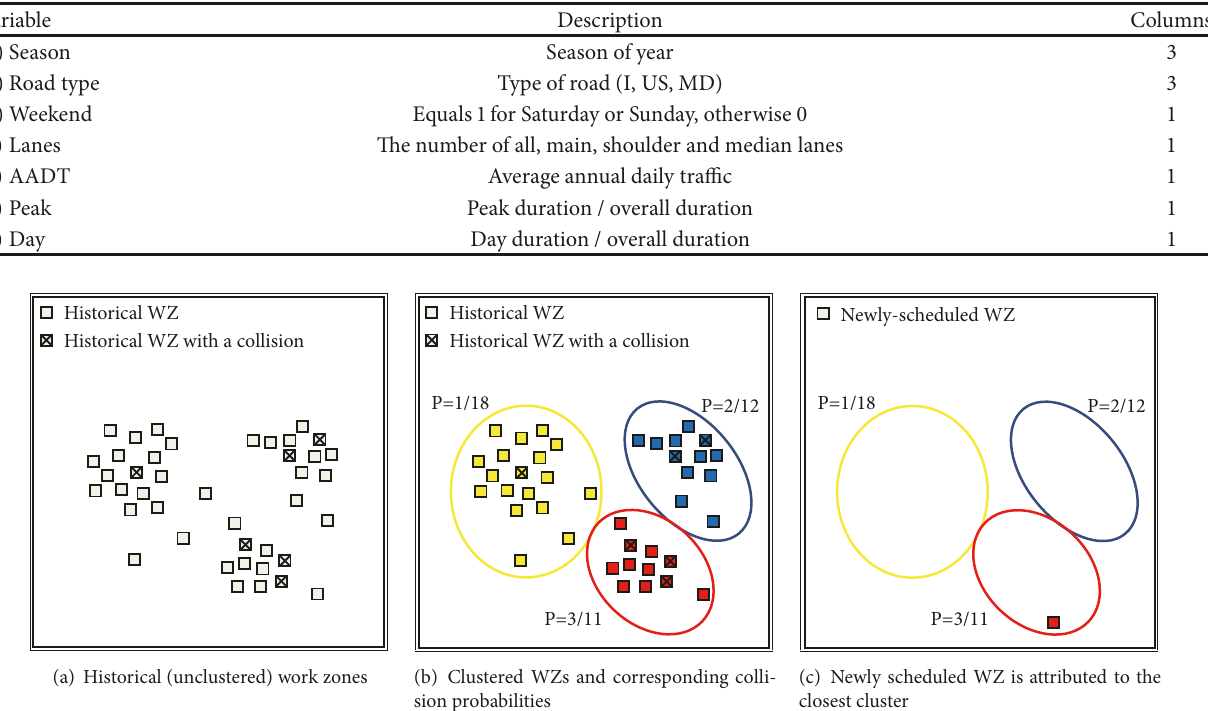
Figure 9: Graphical description of the methodology via a trivial example including 2 dimensions, 3 clusters, and 41 data points (i.e., WZs). After clustering historical WZs, for each cluster, we compute the number of WZs with at least one collision over the total number of WZs within the cluster. A newly scheduled WZ is attributed to the cluster with the most similar features. The predicted probability of a collision occurring at this WZ corresponds to the ratio computed for the cluster it was attributed